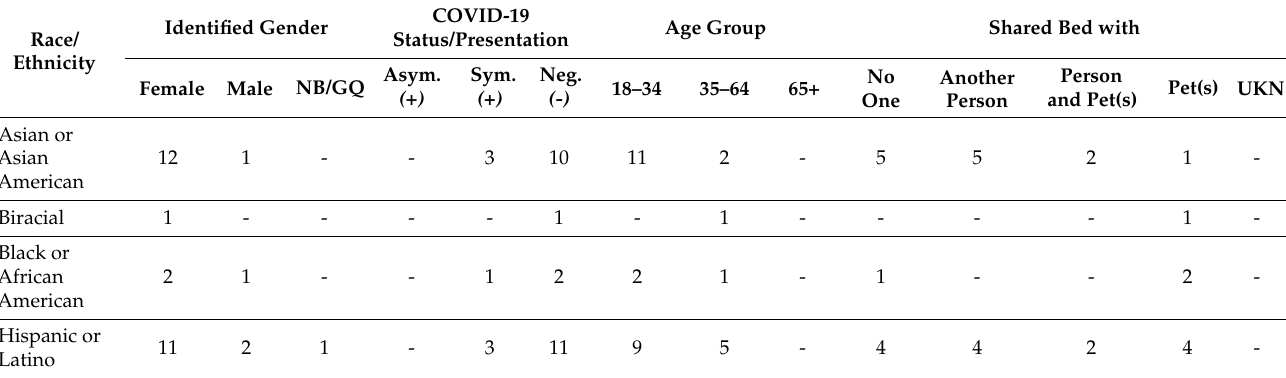
Table 1. Donor demographic data for COVID-19 T-shirt samples used in dog training/testing. Identified Race/ Ethnicity